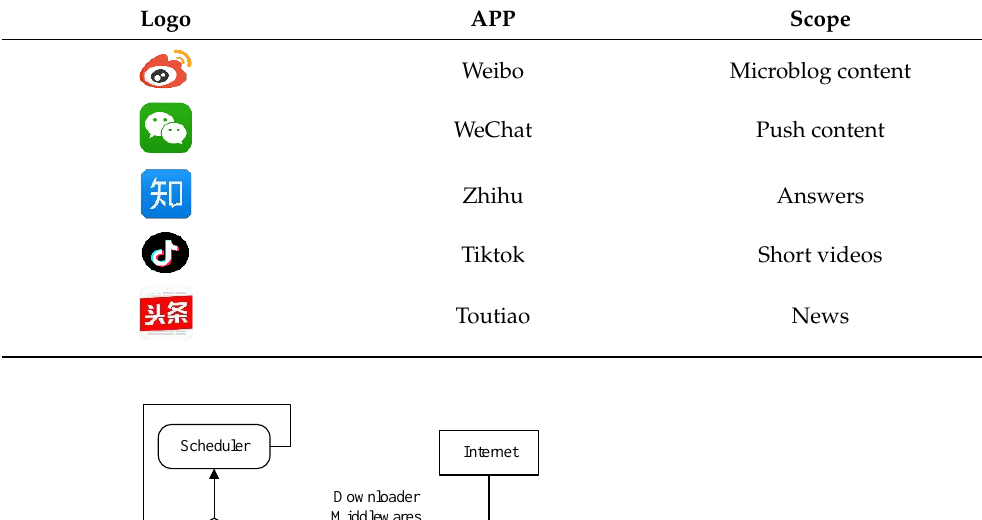
Table 2. Selected apps and relevant acquisition scopes.